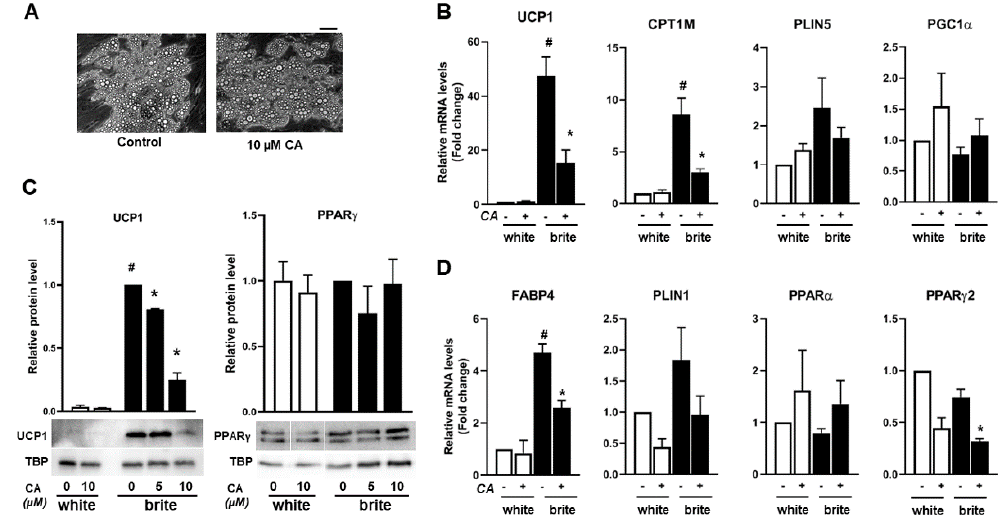
Figure 1. Carnosic acid (CA) inhibits the browning process of human white adipocytes. White human multipotent adipose-derived stem (hMADS) adipocytes were converted (from day 14 to day 18) into brite adipocytes using the peroxisome proliferator-activated receptor γ (PPAR γ ) agonist rosiglitazone in the absence ( − ) or the presence (+) of 10 µM CA (CA): ( A ) photomicrographs of differentiated hMADS cells treated or not with 10 µM CA, bar: 20 µm; mRNA levels of thermogenic ( B ) and adipogenic ( D ) markers; and ( C ) western-blot analysis using 40 (left panel) or 50 (right panel) µg total protein extracts. Histograms display mean ± SEM of three independent experiments; paired student, p < 0.05 was considered significant: #, white vs. brite adipocyte; *, untreated vs. CA treated condition. We had shown previously that activation of PPAR α induces browning of white adipocytes [16].